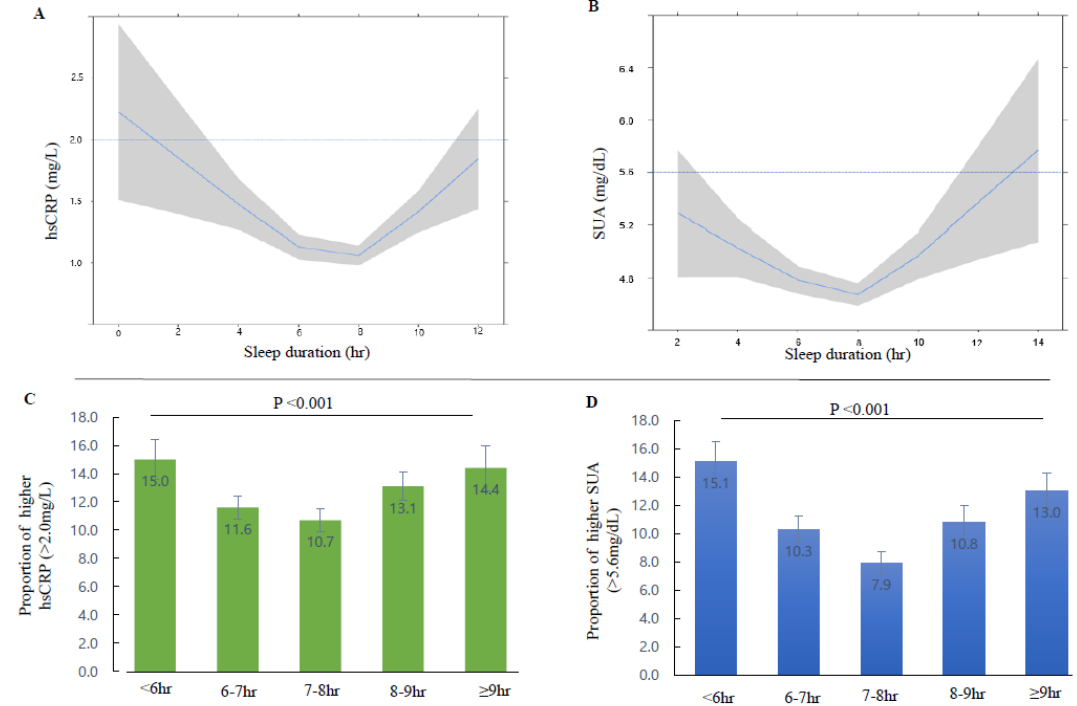
Figure 2. Association between serum high-sensitivity C-reactive protein (CRP), serum uric acid (SUA), and sleep duration in Korean women. ( A ) The relationship between continuous values of hsCRP and sleep duration. ( B ) The relationship between continuous values of SUA and sleep duration. ( C ) The proportion of patients with higher serum hsCRP level according to sleep duration categories. ( D ) The proportion of patients with higher SUA level according to sleep duration categories. Solid blue line (restricted cubic spline regression line) indicate predicted hsCRP and SUA by sleep duration and shaded area indicate the 95% confidence intervals.